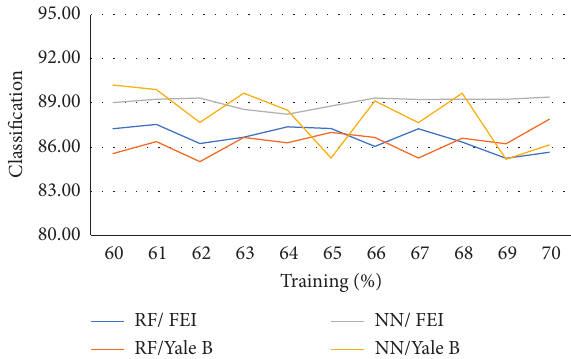
Figure 12: The classification results of the BLCM method using 60% to 70% of the training data (FEI and Yale B datasets) and the classification performance of NN and RF. Table 3: The mean and standard deviation results for the BLCM methods using the random forest and the neural network (NN) classifier with the FEI dataset and the Yale B dataset.